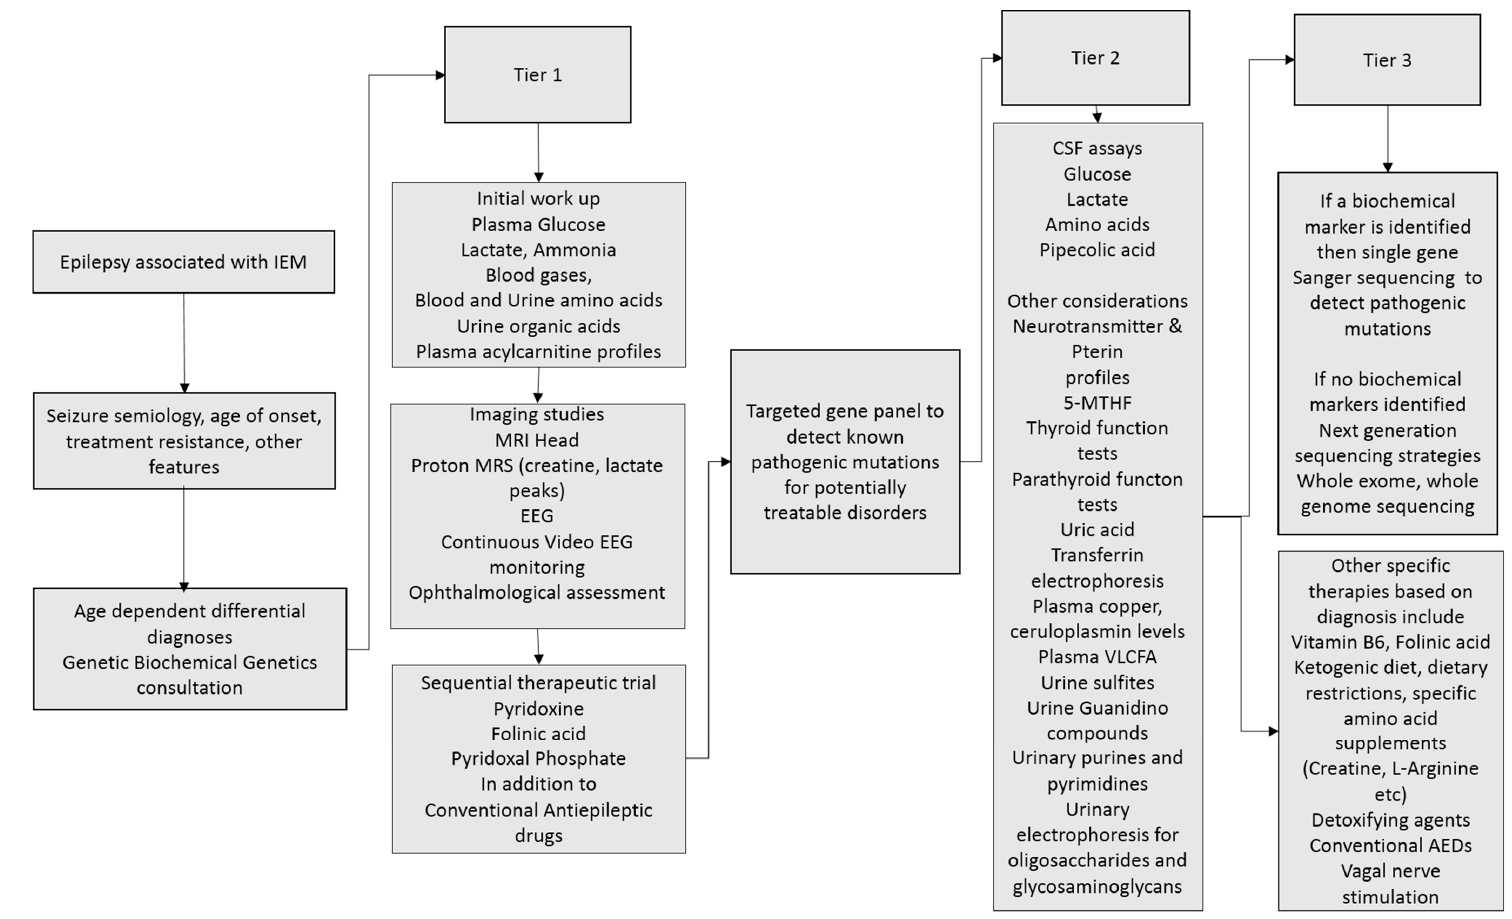
Figure 1. Epilepsy associated with IEM; suggested tiered approach to investigation, diagnosis, and management.